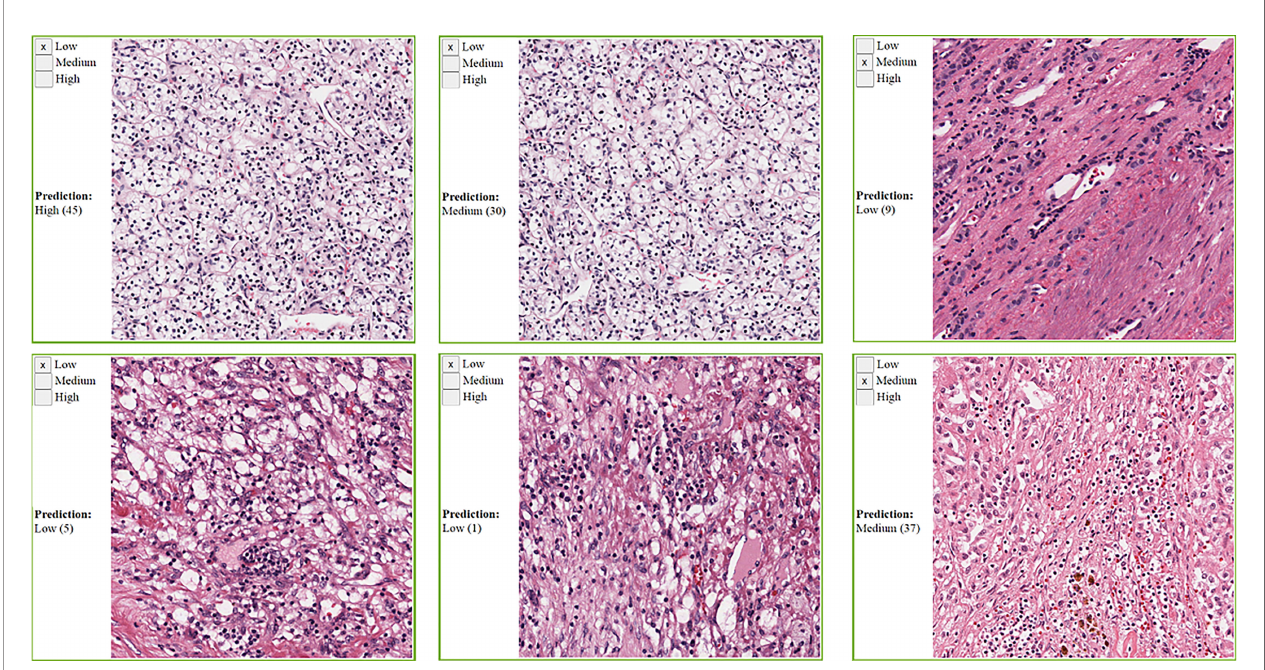
FIGURE 7 | Sample KIRC super-patches, showing the categorical label and the Inception model prediction. KIRC is challenging because other cell types nuclei can look like lymphocytes. The model prediction is displayed as a category and a score between brackets. The models ’ scoring is a value in the range 0 to 64. We roughly interpret it as: Low if 0 ≤ score ≤ 21, Medium if 22 ≤ score ≤ 42, and High otherwise. Top row: cases where the category approximated from the model scoring does not match the pathologists ’ label. Bottom row: cases where the category approximated from the model scoring matches the pathologists ’ label.